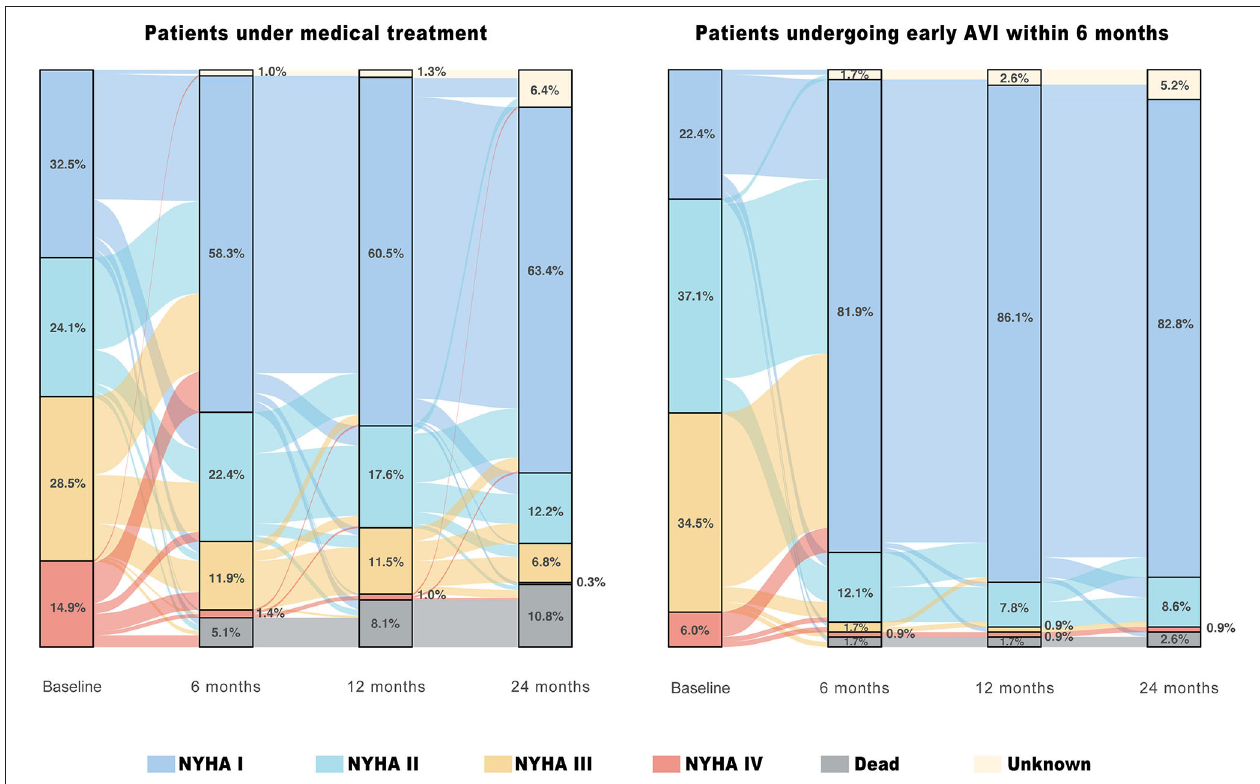
FIGURE 4 | Temporal course of symptom status in patients with moderate AR and LVSD (LVEF ≤ 55%) under different treatment strategies. The river plots show the changes in New York Heart Association (NYHA) functional classification for patients under medical treatment who at least survived and were followed up for 15 days and for patients undergoing early aortic valve intervention (AVI) within 6 months of the baseline